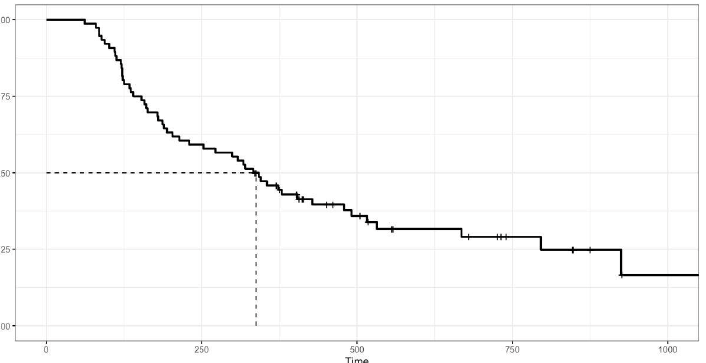
Figure 1. Kaplan–Meier survival curve showing overall median survival of 76 cats with mediastinal lymphoma treated with COP chemotherapy. Median survival time was 338 days (range 62–1057 days).